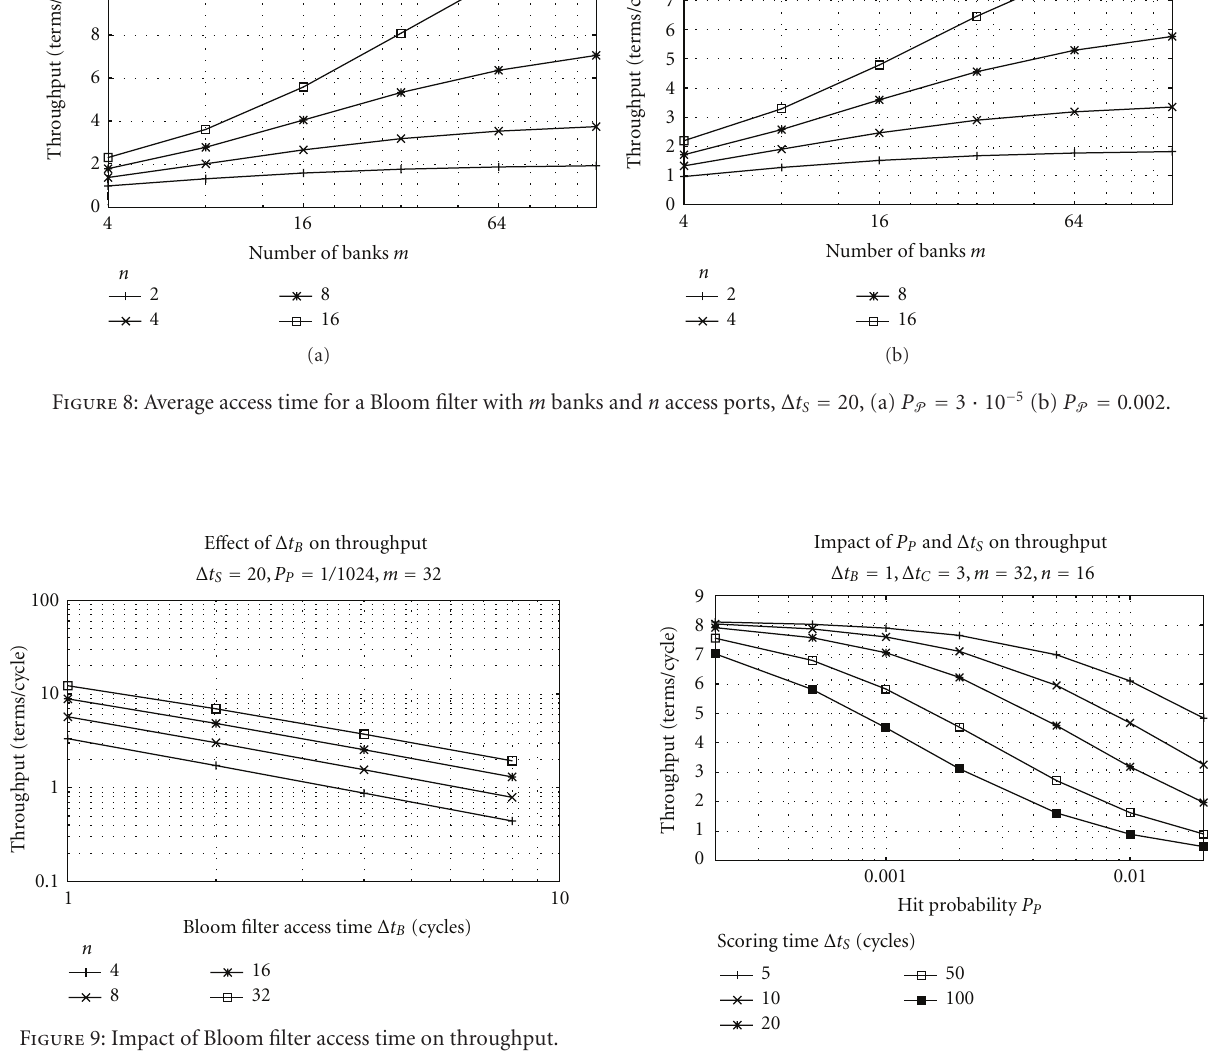
Figure 10: Impact on throughput of hit probability and external memory access